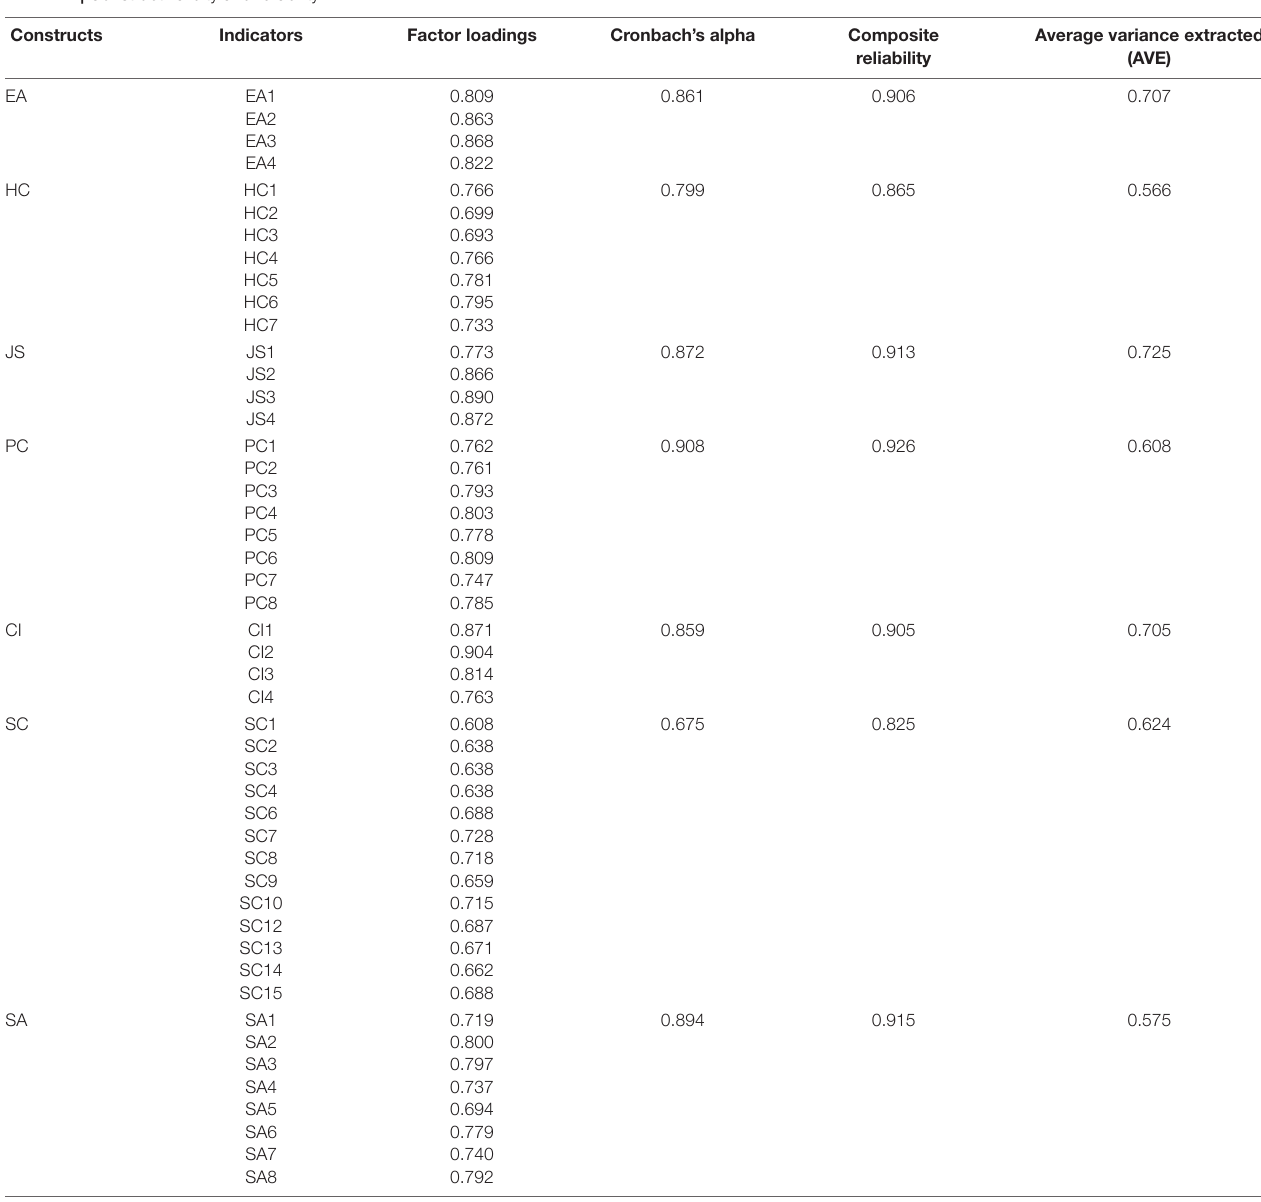
TABLE 1 | Construct validity and